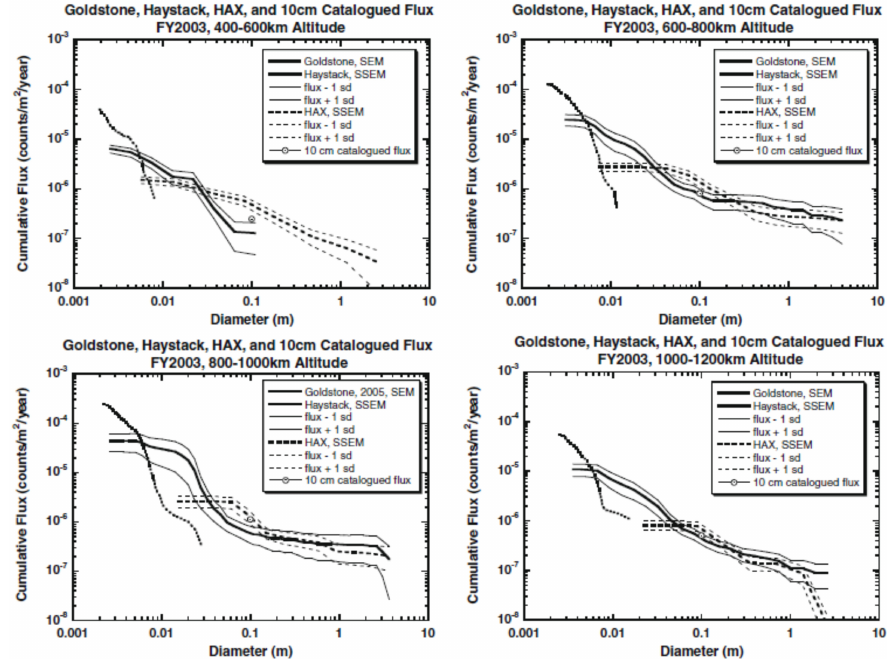
Figure 10. Debris flux versus diameter at different altitudes for the Goldstone, Haystack, HAX radars during fiscal year 2003 [22]. Reprinted from Advances in Space Research, Copyright 2009, with permission from